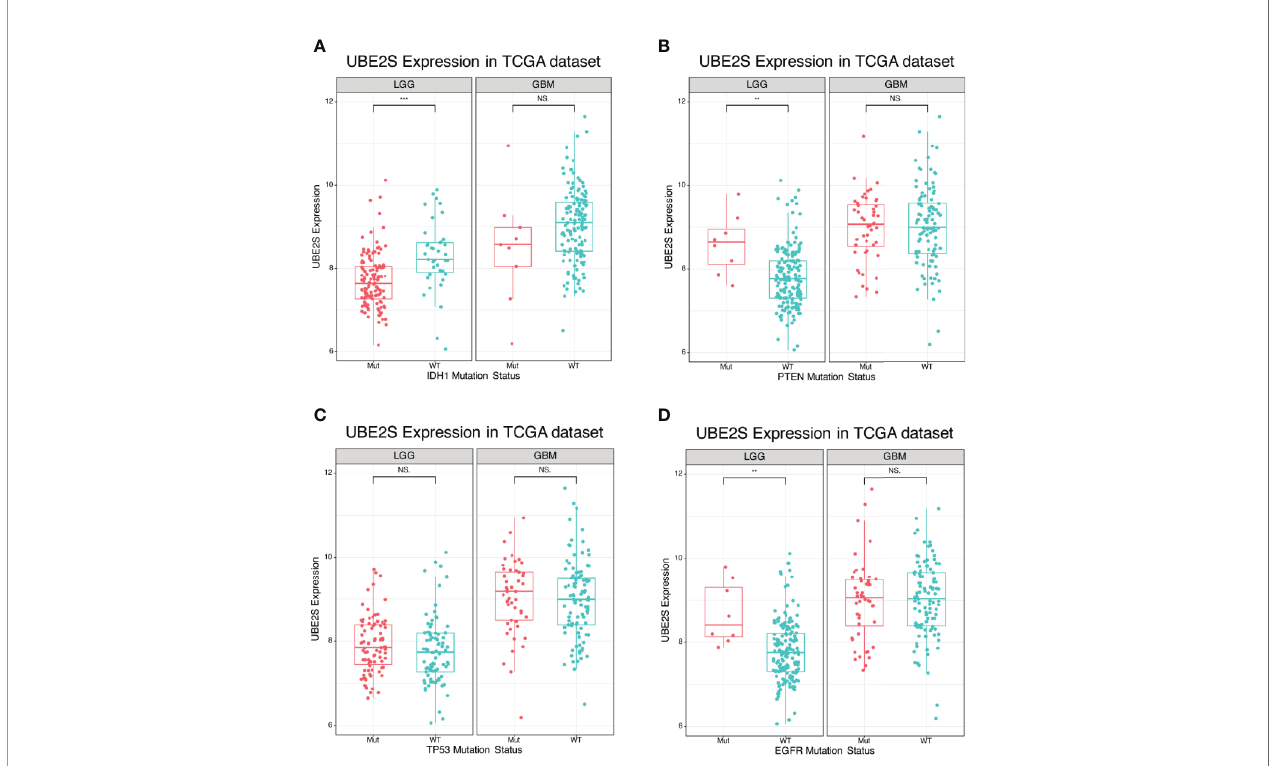
FIGURE 2 | Expression of UBE2S in glioma of different mutation types. (A) UBE2S was signi fi cantly upregulated in IDH1 wild-type LGG glioma in TCGA data set compared with the mutants. (B) UBE2S was signi fi cantly upregulated in PTEN mutation LGG glioma in TCGA data set compared with the wild-type. (C) UBE2S expression was not signi fi cantly different between TP53 mutation and TP53 wild-type LGG/GBM glioma in TCGA data set. (D) UBE2S was signi fi cantly upregulated in EGFR mutation LGG glioma in TCGA data set. Wilcoxon test was used to determine statistical difference. ***P < 0.001, **P < 0.01, NS represents non-signi fi